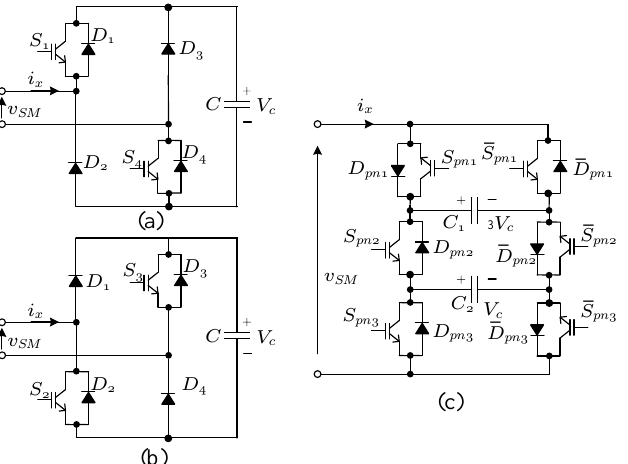
Figure 12. CSC and AC-AC SMs: ( a ) DBSM-1—Diagonal bridge SM 1; ( b ) DBSM-2—Diagonal bridge SM 2; and ( c ) 7L-PUC—7-Level Packed